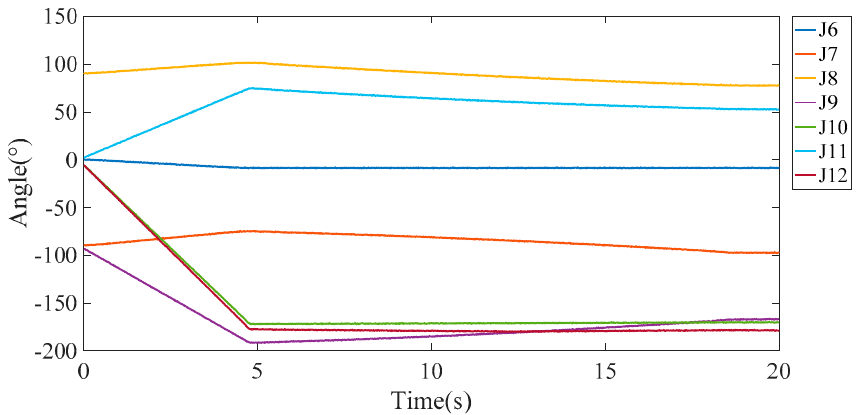
Figure 25. The joint angles of the redundant manipulator in the experiment.